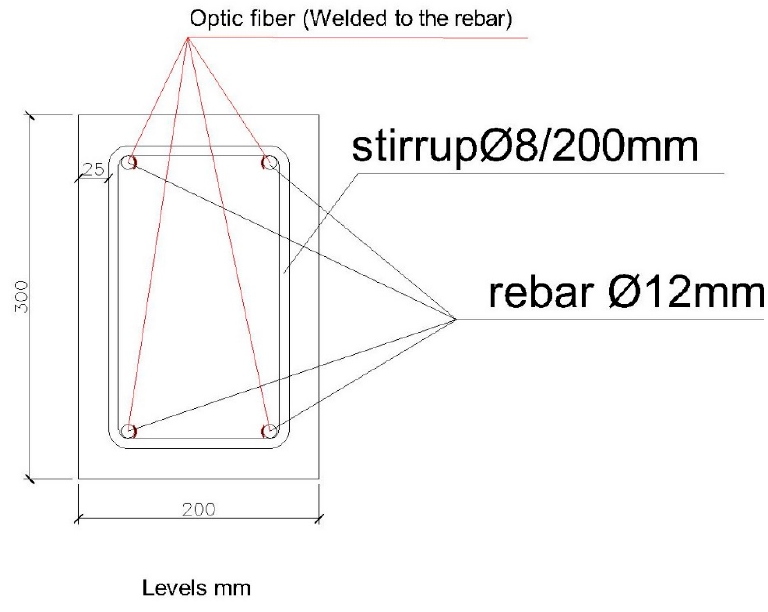
Figure 4. Beam section 200 × 300 mm.